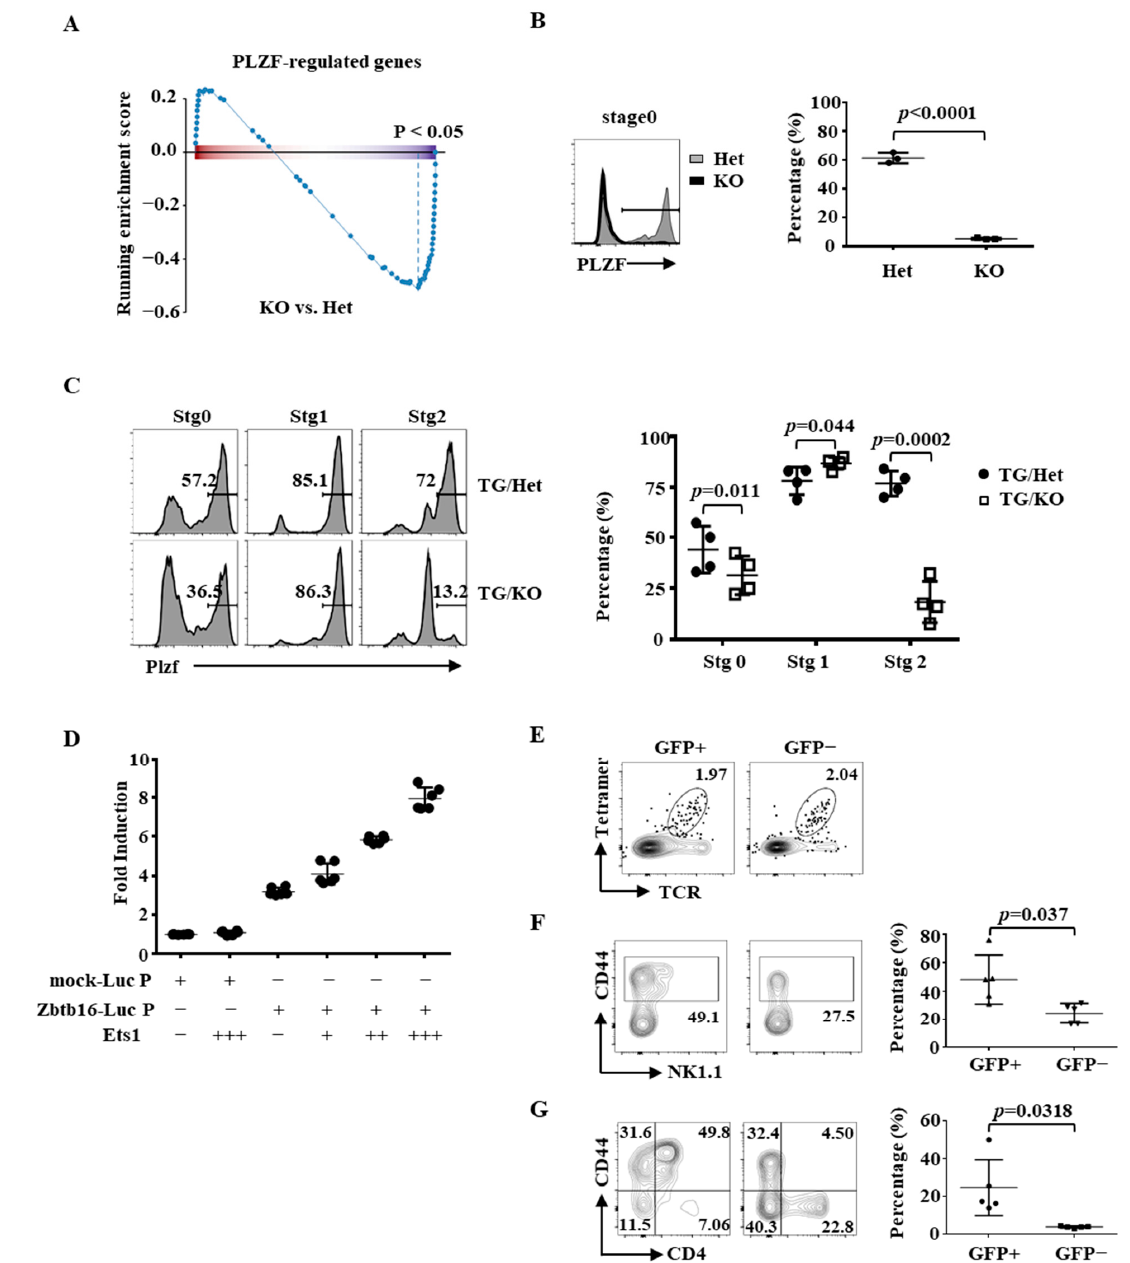
Figure 6. Partial rescue of the differentiation/homeostasis of TG/KO iNKT with PLZF. ( A ) The result of GSEA analyses of Zbtb16 regulated genes is shown. ( B ) PLZF staining of stage 0 iNKT cells of the indicated genotypes is shown. The cumulative results are shown in the right panel. ( C ) PLZF staining of iNKT cells from various stages and indicated genotypes is shown. The cumulative results are shown in the right panel. ( D ) 293 cells were transfected with luciferase reporter only (mock-Luc P) or with Zbtb16 promoter region (Zbtb16-Luc P) and different amounts of Ets1 expression plasmid. The luciferase activity was normalized against internal control obtained from renilla luciferase activity. The normalized activity obtained from mock-Luc was arbitrarily set as 1. The data shown are from three independent experiments. ( E – G ) Splenocytes of CD45.1 WT mice reconstituted with GFP-PLZF retrovirus-transduced CD45.2 TG/KO bone marrow cells were separated into CD45.2+GFP+ (transduced) and CD45.2+GFP − (un-transduced) populations and then, iNKT cells were identified with TCR/CD1d-tetramers ( E ). The distribution of stage 1, 2, and 3 as well as the expression of CD4 in GFP+ and GFP − CD45.2 iNKT cells were examined by FACS. Representative NK1.1/CD44 ( F ) and CD44/CD4 ( G ) plots and cumulative data from six mice (the right panels of ( F , G )) are shown. Statistical analyses were performed with a paired Student’s t